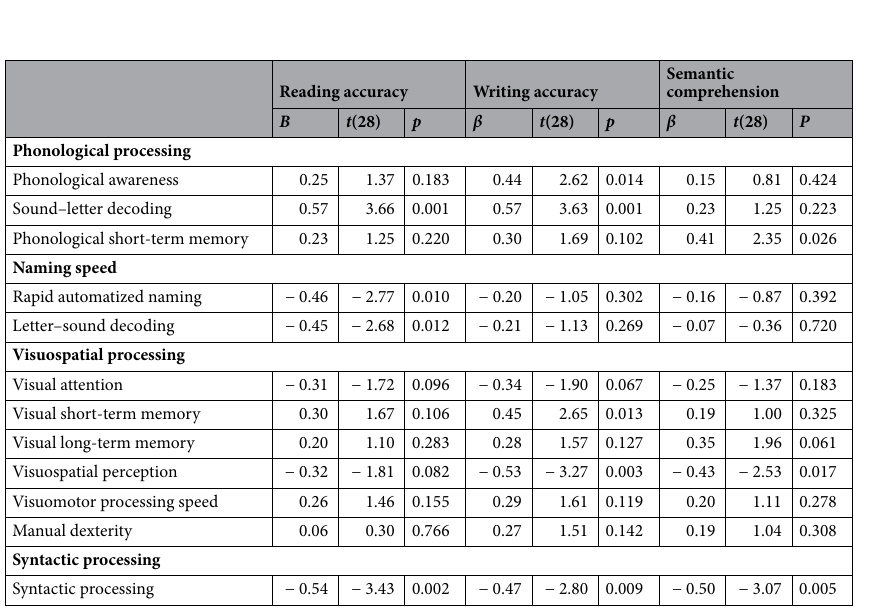
Table 3. Results of simple linear regression analyses including cognitive skills as predictors and kanji abilities as outcomes. Note: n = 30. β standardized regression coefficient, p-value significance in t